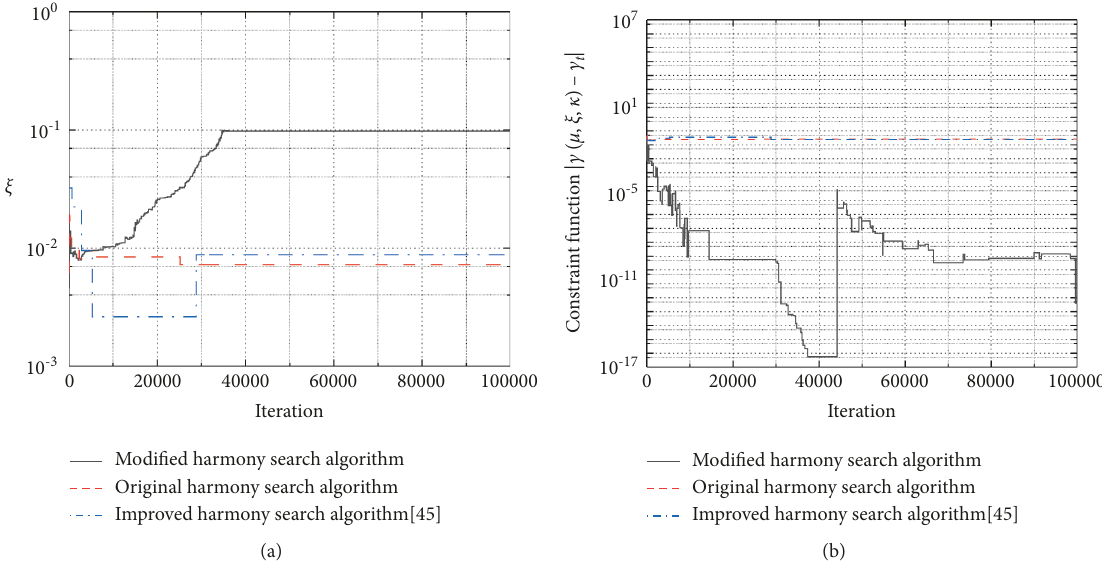
Figure 12: The variation trends of key indices during the optimization process for case 8. (a) The nominal damping ratio ξ . (b) The constraint function | c ( μ , ξ , κ ) − c t |